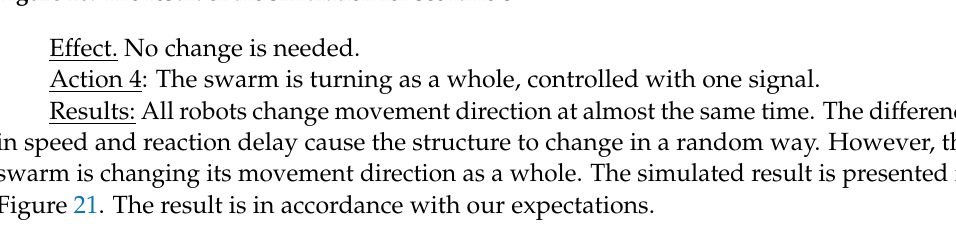
Figure 20. The result of the simulation for scenario 3.